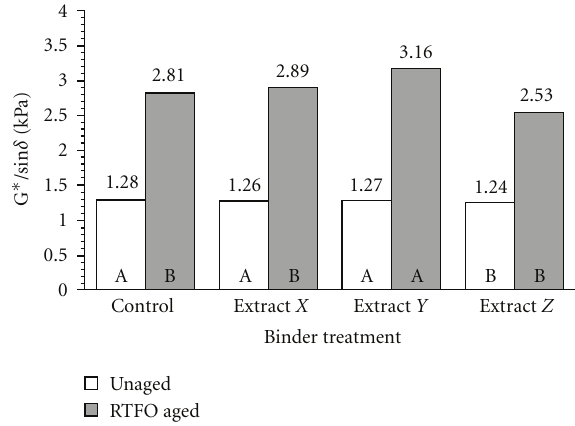
Figure 10: Original and RTFO aged G ∗ / sin δ of control binder and binder with finish extracts tested at 64 ◦ C. Statistical comparisons were made within each stage of aging.